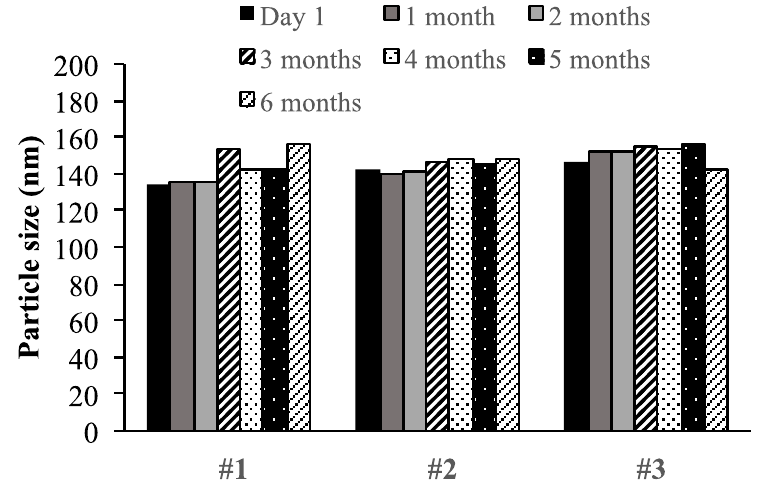
Figure 2. Long-term stability of CUR MT NPs stored at 4 °C. Three different batches of CUR MT NPs were monitored for particle size over 6 months. For all tested samples, P.I. < 0.25. Data are presented as the mean particle size of each batch. Particle size did not significantly change over the tested period ( p > 0.05 for each batch).